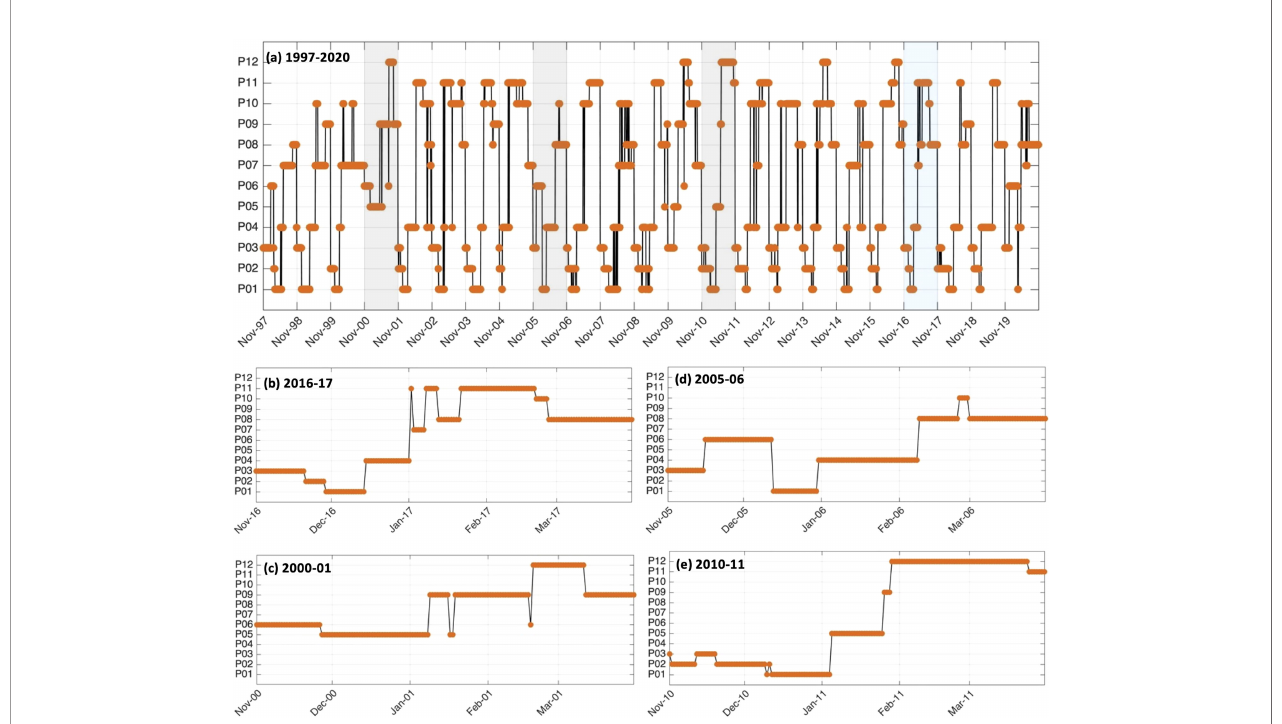
FIGURE 5 | BMU timeseries indicating the daily evolution the SOM 12 patterns (P1 to P12) during all Nov-Mar (A) 1997-2020, a typical patterns ’ sequence (B) 2016-17 and the anomalous events (C) 2000-01, (D) 2005-06 and (E)